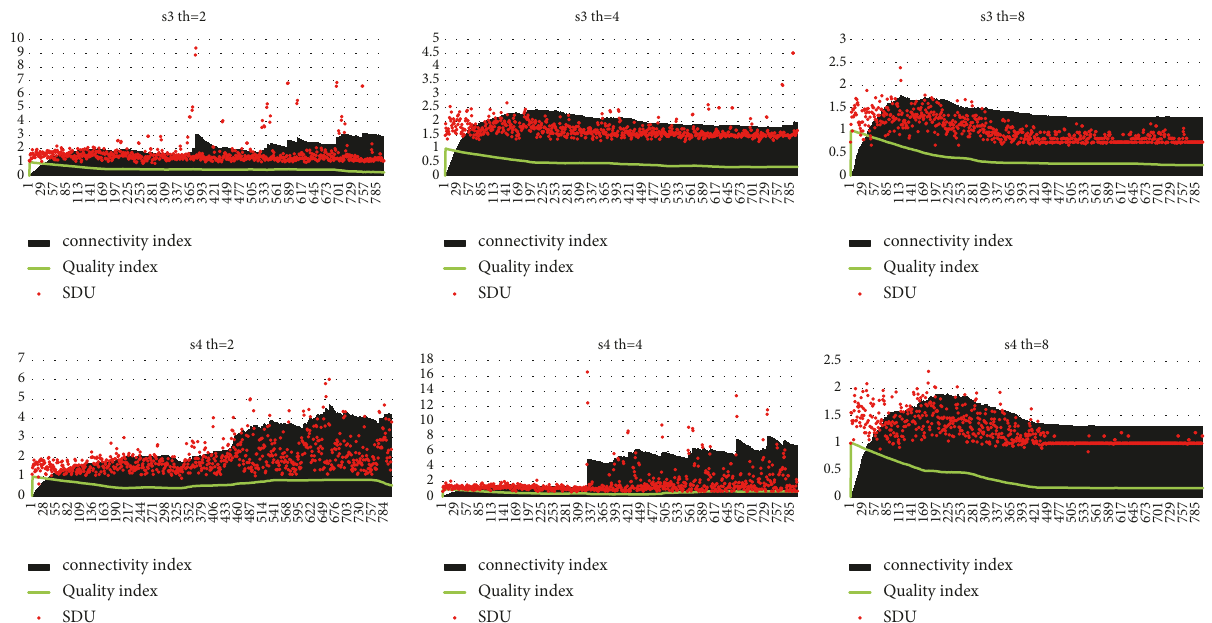
Figure 8: Phase shift analysis. Each graph above shows a time-series plot of 800 hours. Quality index is shown through green line. The SDU is shown through red points, and quality index is shown through bars fillings in black. The top row is of s3, followed by s4. The columns represent 𝑡ℎ 𝑠𝑡𝑟𝑜𝑛𝑔−𝑡𝑖𝑒 = 2 (column 1), 𝑡ℎ 𝑠𝑡𝑟𝑜𝑛𝑔−𝑡𝑖𝑒 = 4 (column 2), and 𝑡ℎ 𝑠𝑡𝑟𝑜𝑛𝑔−𝑡𝑖𝑒 = 8 (column 3). These graphs correspond to 550 vehicles and 15